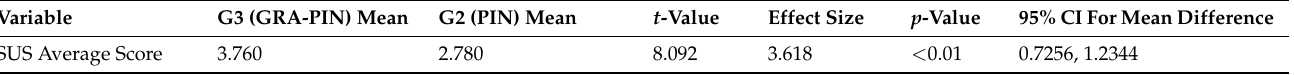
Table 6. T -test evaluation for G2 and